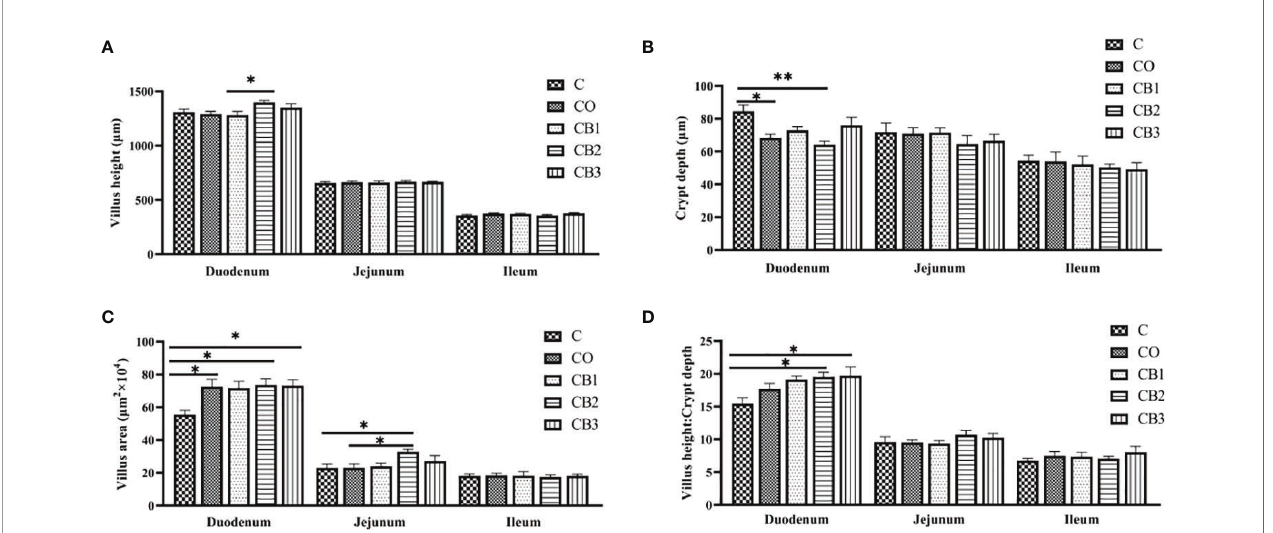
FIGURE 3 | Effects of dietary chitosan oligosaccharides (COS) and Clostridium butyricum synbiotic supplementation on small intestine morphometric traits of three segments (duodenum, jejunum, and ileum) in early-weaned pigeon squabs. (A) Villus height. (B) Crypt depth. (C) Villus area. (D) The ratio of villus height to crypt depth. Values are means with the SEM of eight squabs. * p < 0.05 and ** p < 0.01. C group, control group, squabs fed with arti fi cial crop milk; CO group, squabs fed with arti fi cial crop milk + 150 mg/kg COS; CB1, CB2, and CB3 group, squabs fed with arti fi cial crop milk + 150 mg/kg COS + 200, 300, and 400 mg/kg C. butyricum , respectively.